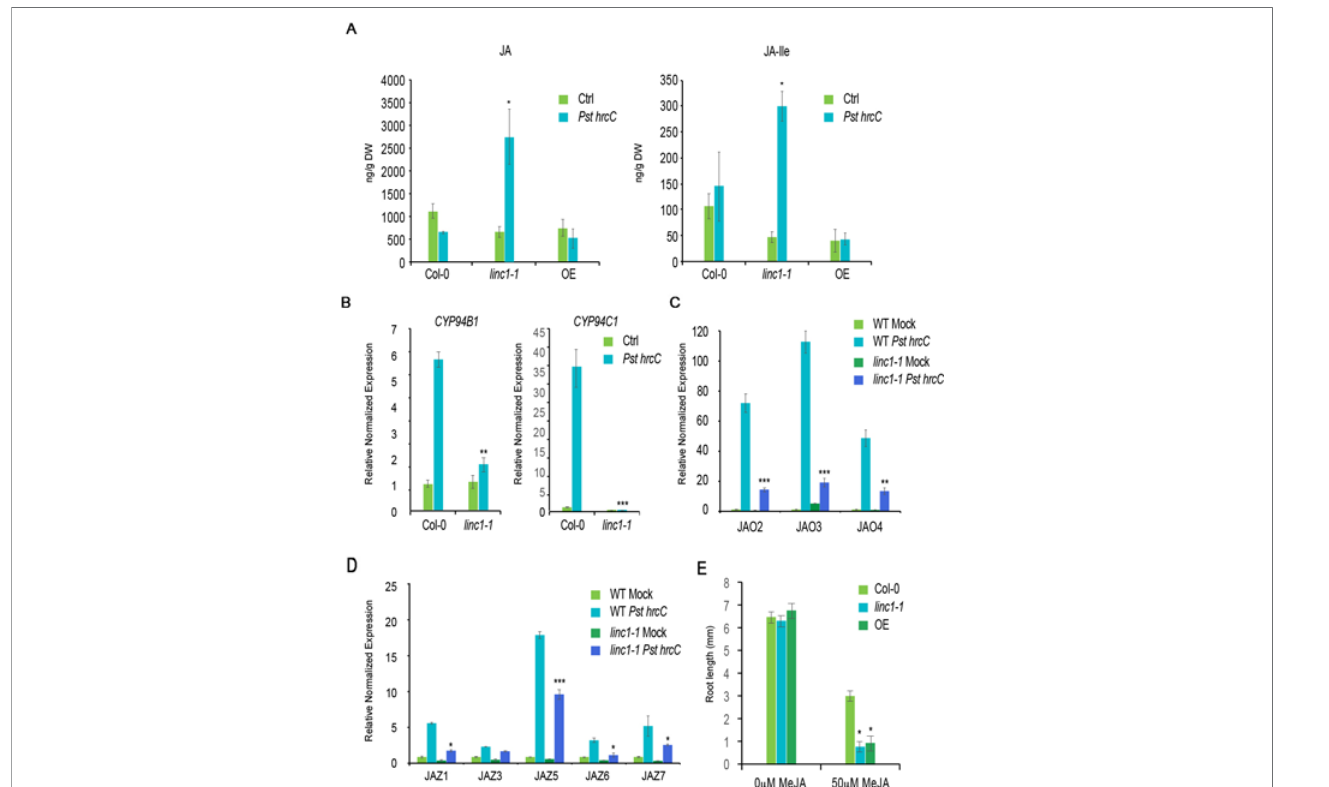
FIGURE 4 | LINC1 modulates JA accumulation and signaling. (A) JA and JA-Ile levels in wild-type, linc1-1 and OE plants. Leaves of 3 – 4 weeks-old wild-type and linc1-1 mutant were in fi ltrated with Pst hrcC - (OD 600 nm = 0.2). (B) 14-d-old seedlings were treated with Pst hrcC - for 24 h and harvested later to isolate RNA and cDNA preparation. qRT-PCR analysis of CYP94B1 and CYP94C1 genes regulated by LINC1 . (C) qRT-PCR analysis of JAO2 , JAO3 and JAO4 genes regulated by LINC1 . (D) qRT-PCR analysis of JAZ1,3,5,6 and 7 genes regulated by LINC1 . Gene expression was normalized to internal control UBQ10 and actin. (E) Both linc1-1 and OE plants show increased sensitivity to MeJA compared to wild type plants. Values are averages ± SE of three biological replicates consisting of pools of 12 seedlings. The data are shown in (A – E) are means from three biological replicates. Statistical signi fi cance was analyzed by two-way ANOVA, asterisk